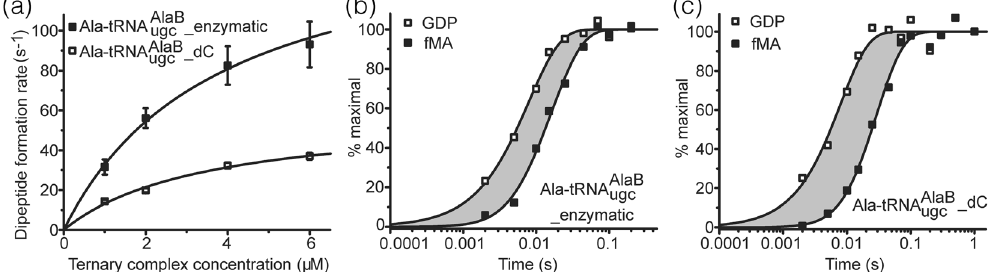
Figure 3. Kinetics of fMA dipeptide formation from fMet-tRNA fMet and Ala-tRNAs. ( a ) Plot of the rates of dipeptide formation versus ternary complex concentrations. Mean values and standard deviations were calculated from at least two independent experiments (see Supplementary Table 1 and Supplementary Figure 2). The smooth curves show the fitting of the data to a hyperbolic Michaelis-Menten equation. ( b ) and ( c ) Plots of representative normalized time-evolution of GTP hydrolysis and dipeptide formation versus time for reactions with Ala-tRNA AlaB ugc _enzymatic ( b ) and Ala-tRNA AlaB ugc _dC ( c ). The shaded areas show the overall mean time of passage from the A/T state after GTP hydrolysis on EF-Tu to peptidyl transfer, τ acc,pep (see Table 1). Experiments were conducted at least in duplicates.